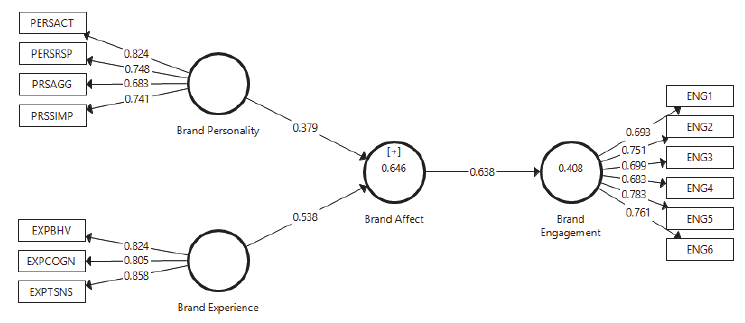
Fig. 1. 2nd stage measurement model